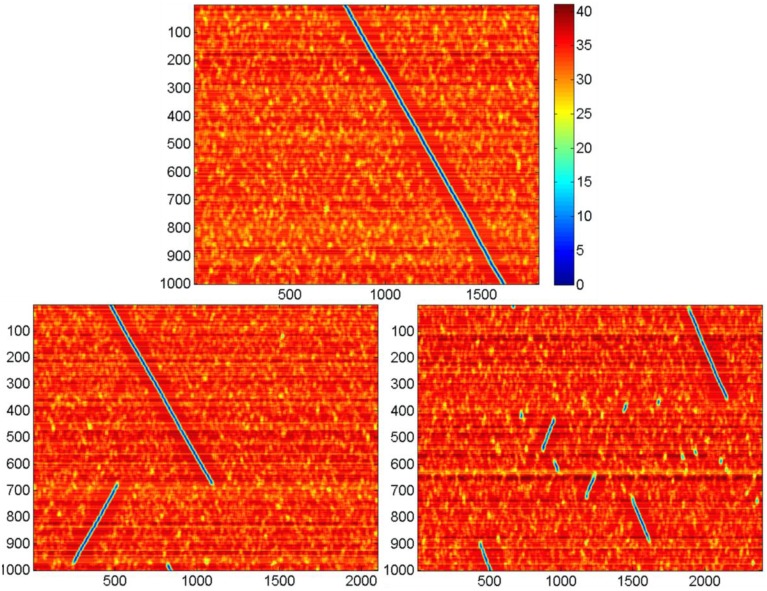
Activity display for the neural networks formed with different values of k. Notations are the same as in Figure 6. N = 300, D = 80, δ = 12, σ = 3, Other parameters are the same, as in Figure 4. Top: k = 6, in this case the activity runs in cycles over all k·N attractor states (not shown); bottom left, k = 7; bottom right, k = 8. Note that for large k the activity jumps between points of attractor significant distances. Each leap of activity is accompanied with change of direction of wave propagation of the ring of attractor states (the incline of blue lines at the figures switches from negative to positive and vice versa after each leap. The number of jumps for the fixed time period increases with values of k. The figure illustrates the method of obtaining data for the Figure 8.